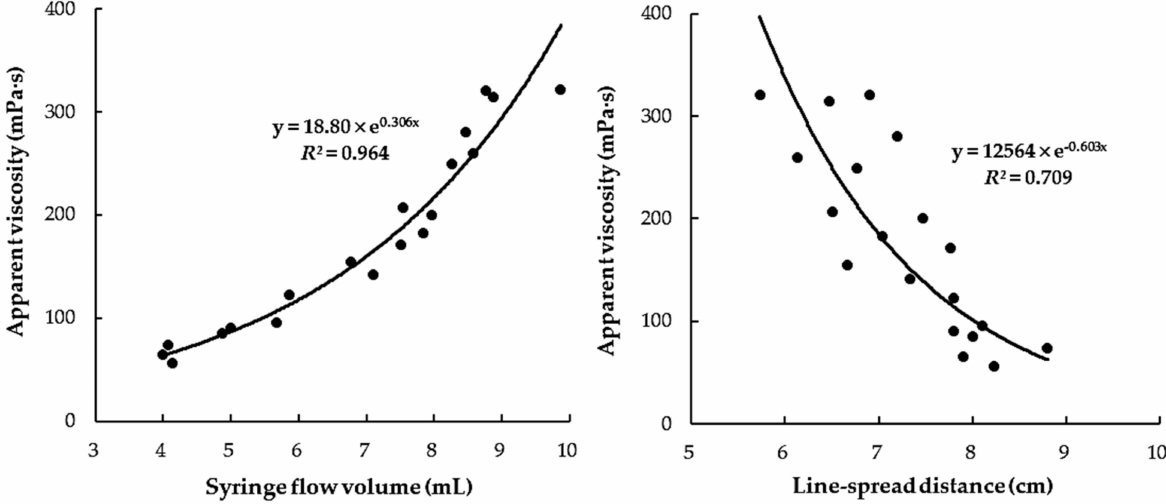
Figure 3. Correlation between apparent viscosity ( η a, 50 ) and flow volume (mL) by SFT or flow distance (cm) by LST of protein-based thickened beverages in nectar-thick range (51–350 mPa · s).